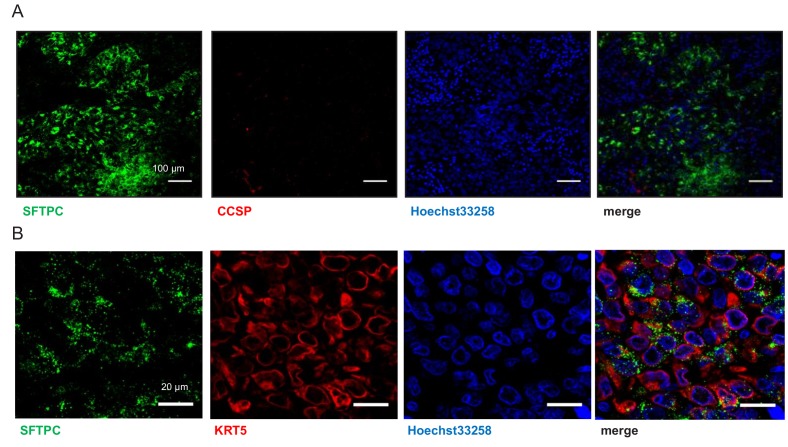
Human lung adenocarcinomas co-express airway and alveolar markers.Co-staining of human lung adenocarcinomas for SFTPC and either CCSP (A; n = 10) or KRT5 (B; n = 10) shows absence of CCSP expression and significant co-localization of SFTPC and KRT5 in a subset of tumor cells. CCSP, Clara cell secretory protein; KRT5, keratin 5; SFTPC, surfactant protein C.